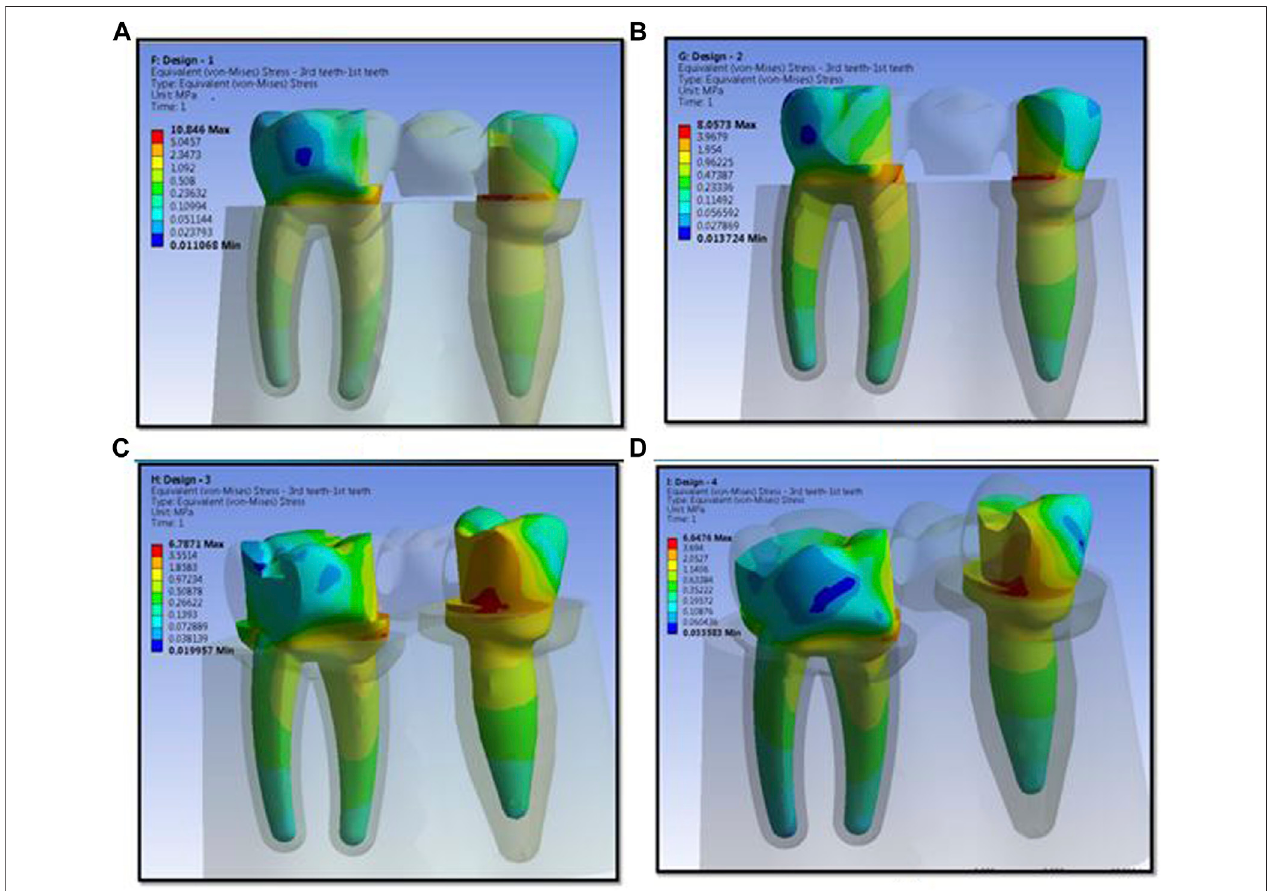
FIGURE 5 | Stress distribution on abutments for design 1 (A) , design 2 (B) , design 3 (C) , and design 4 (D) used in fi nite element analysis.